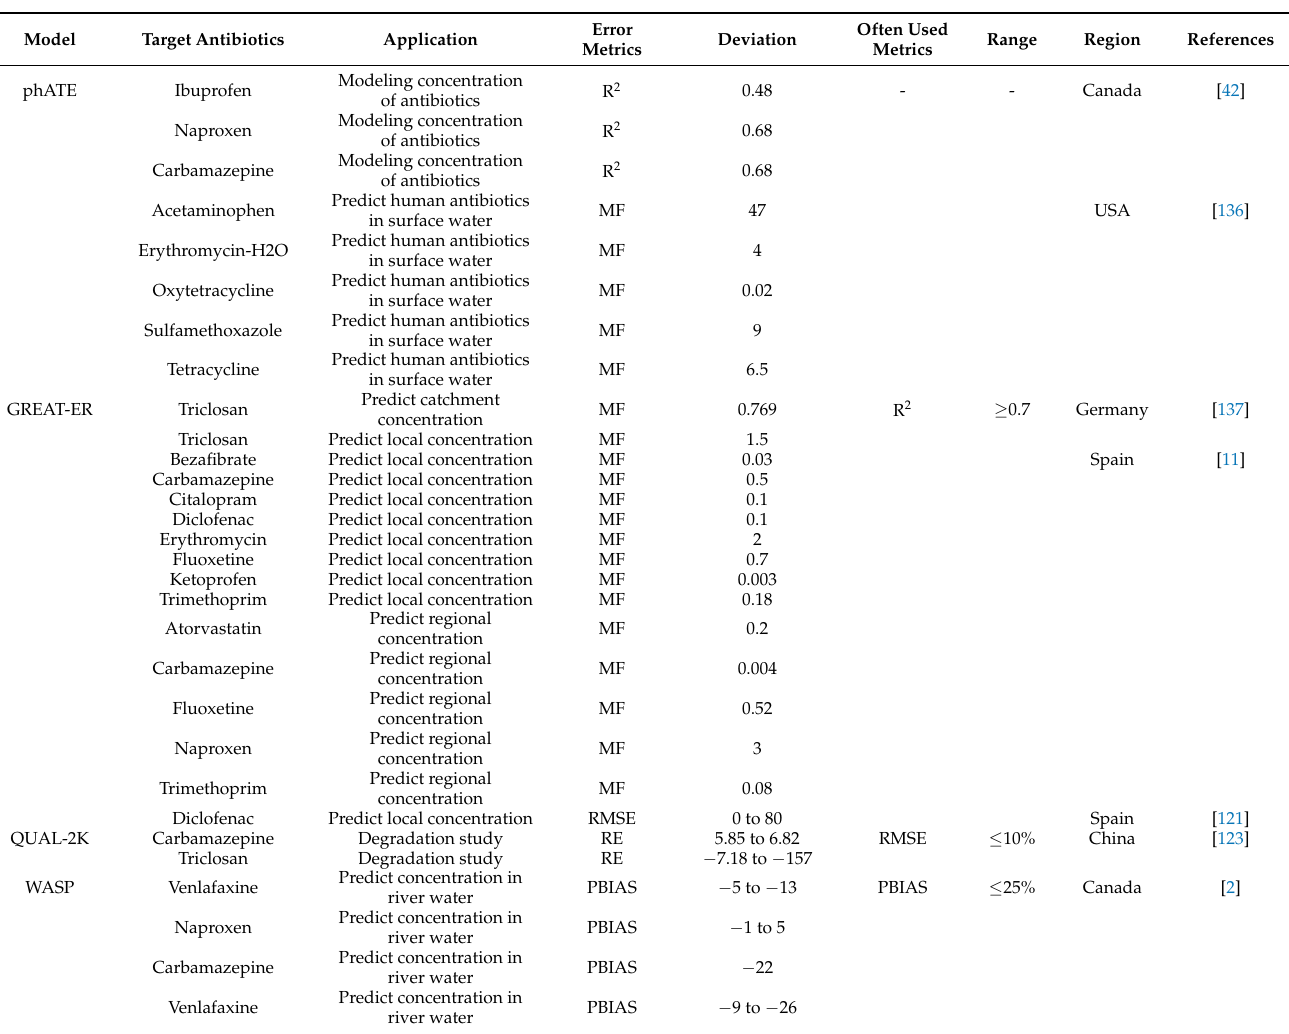
Table 2. Representative model prediction performance evaluation of environmental antibiotic fate model simulation over a regional scale (country) application in different countries across the